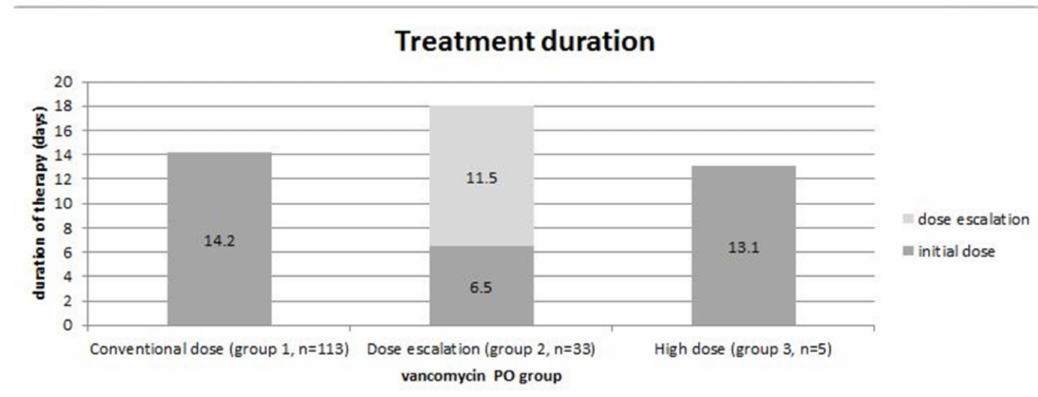
Figure 3. Duration of oral vancomycin therapy by vancomycin